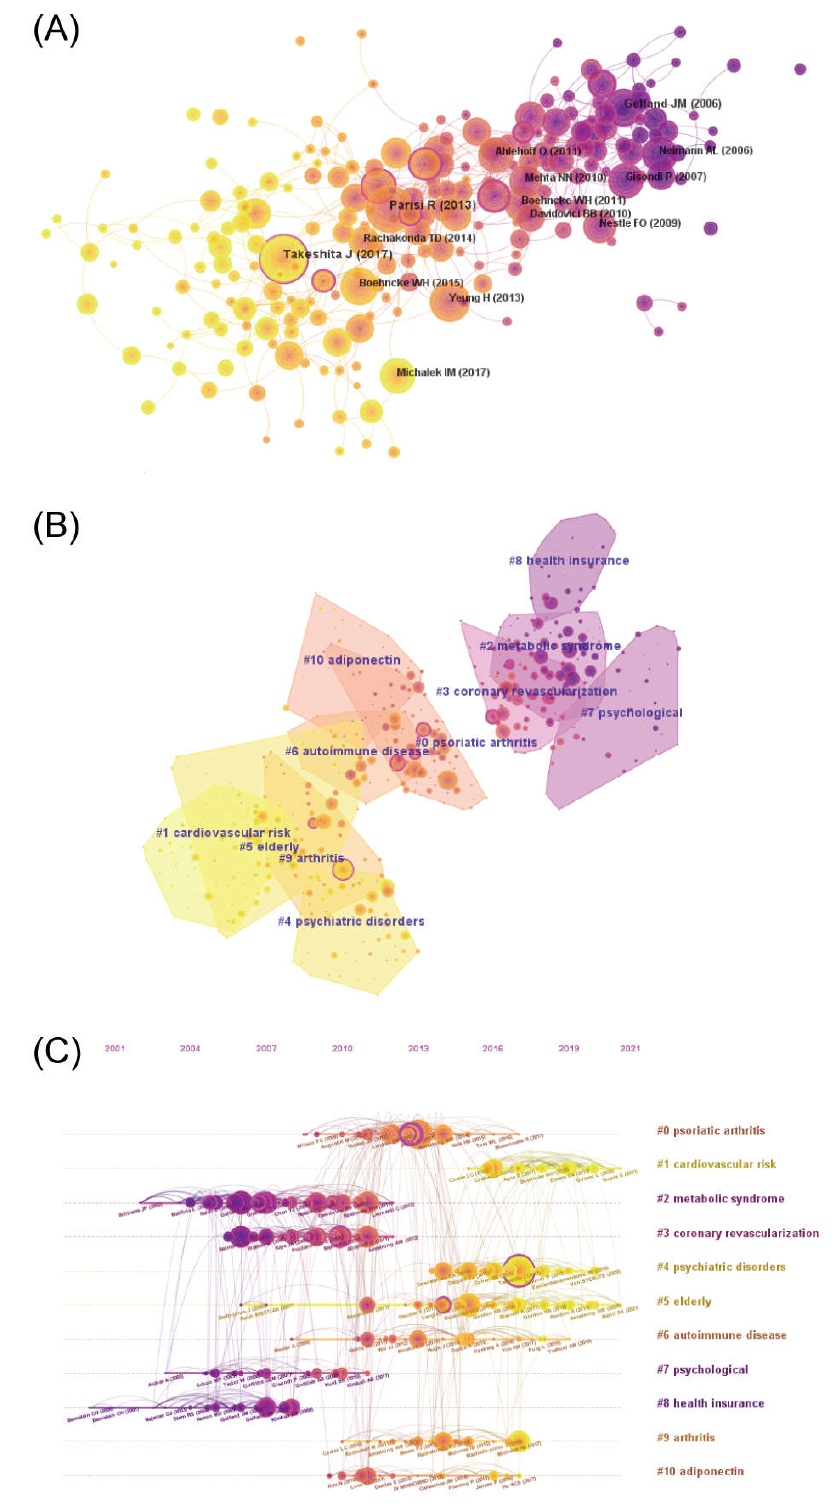
Figure 4. References co-cited in psoriasis co-morbidities. ( A ) The co-cited network of references ( B ) Cluster of reference co-cited ( C ) Timeline of references co-cited.